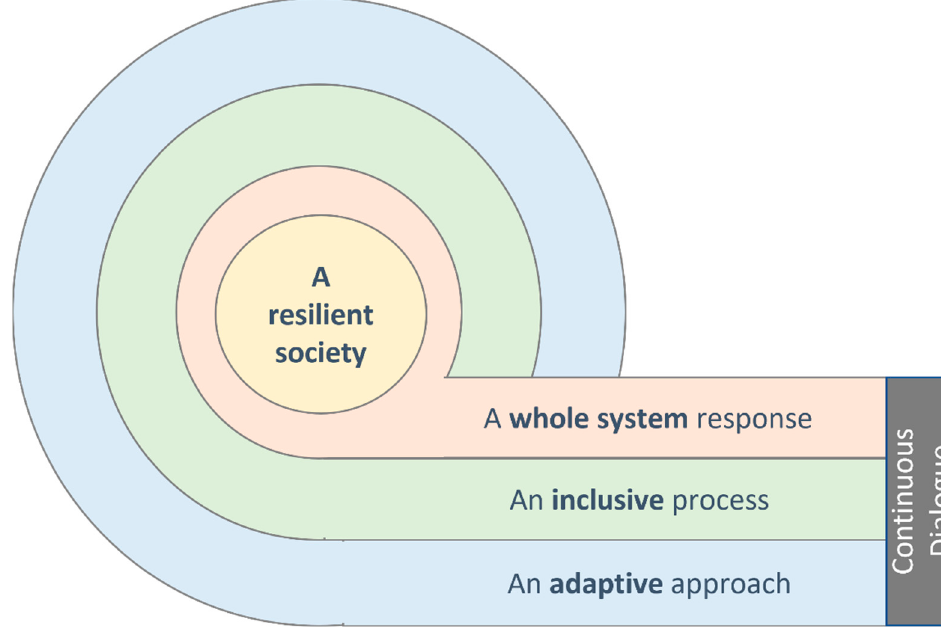
Figure 1. The four pillars of the Cloud to Coast framework to support the transition to a resilient society.